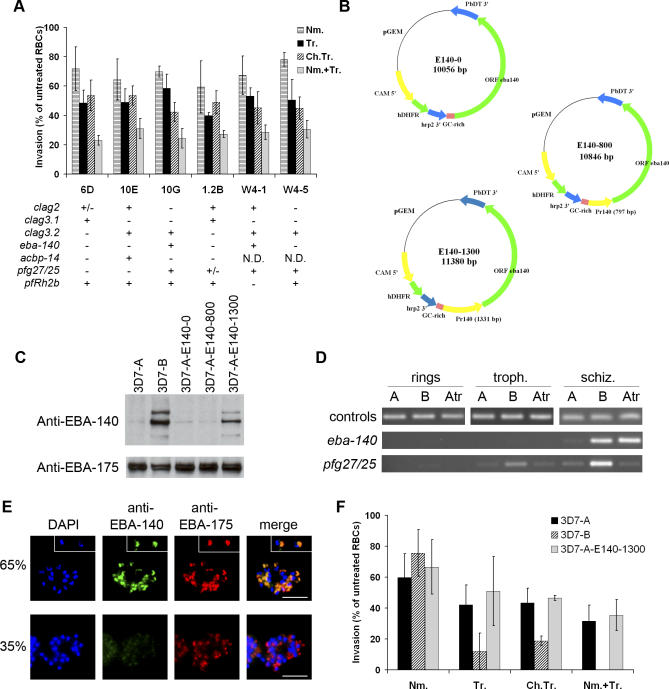
Invasion Phenotypes Associated with the Expression Status of Variantly Expressed Invasion-Related Genes(A) Invasion phenotype of 3D7-A subclones. Values correspond to percent of invasion into untreated erythrocytes and are the average of three to four independent experiments, with 95% confidence interval. Expression of genes that vary in expression between the subclones is shown underneath. The signs + and − correspond to high or low expression relative to other subclones. N.D., not determined; Nm., neuraminidase; Tr., trypsin; Ch.Tr, chymotrypsin; Nm.+Tr, neuraminidase plus trypsin.(B) Scheme of the plasmids transfected in 3D7-A parasites for the episomal expression of EBA-140.(C) Western blot analysis of schizont extracts, as in Figure 2A. Lanes are 3D7-A, 3D7-B, or 3D7-A parasites transfected with the different plasmids, as indicated.(D) RT-PCR analysis at different stages of the life cycle in 3D7-A (lanes A), 3D7-B (lanes B), and E140-1300-transfected 3D7-A (lanes Atr). The amount of stage-specific cDNA was controlled by amplification of the genes PF13_0275 (rings), PF10_0121 (trophozoites), and ama1 (PF11_0344) (schizonts).(E) IFA of E140-1300-transfected 3D7-A schizonts. Top and lower panels are representative of 65% and 35% of EBA-175-positive schizonts, respectively. The inserts in the top panels are free merozoites. Scale bar = 5 μm.(F) Invasion phenotype of E140-1300-transfected 3D7-A parasites compared to that of 3D7-A and 3D7-B. Values correspond to percent of invasion into untreated erythrocytes and are the average of two independent experiments, with 95% confidence interval.